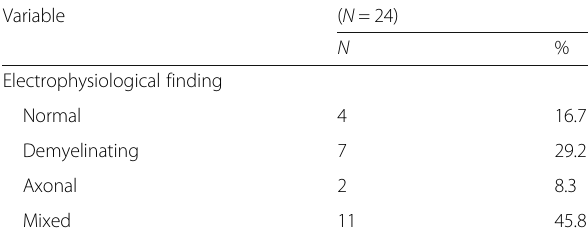
Table 3 Types of electrophysiological findings of the studied